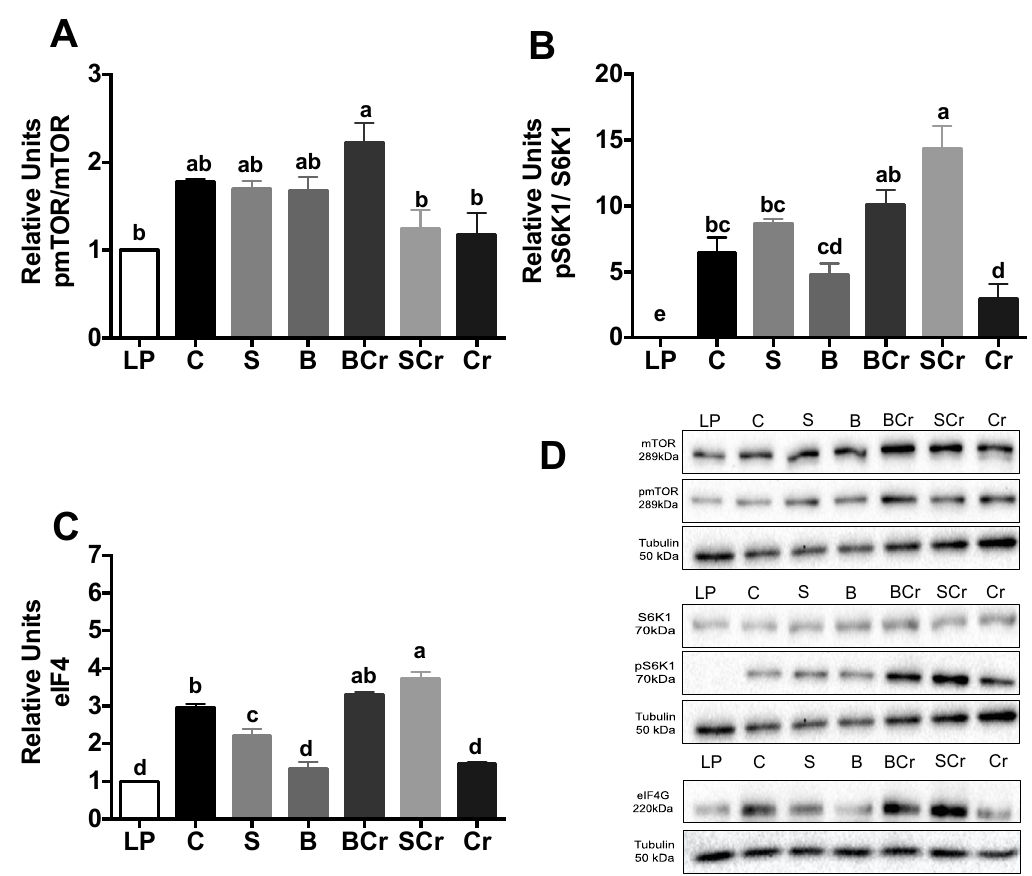
Figure 5. Western blot analysis and quantification of the: ( A ) phosphorylation of mTORC1; ( B ) phosphorylation of S6K1; and ( C ) protein abundance of eIF4G in the livers of rats fed different types of proteins after a protein restricted period; and ( D ) representative Western blot analysis. Values are means ± SEM, n = 3. Different letter superscript indicates significant differences among groups, p < 0.05, a > b > c.